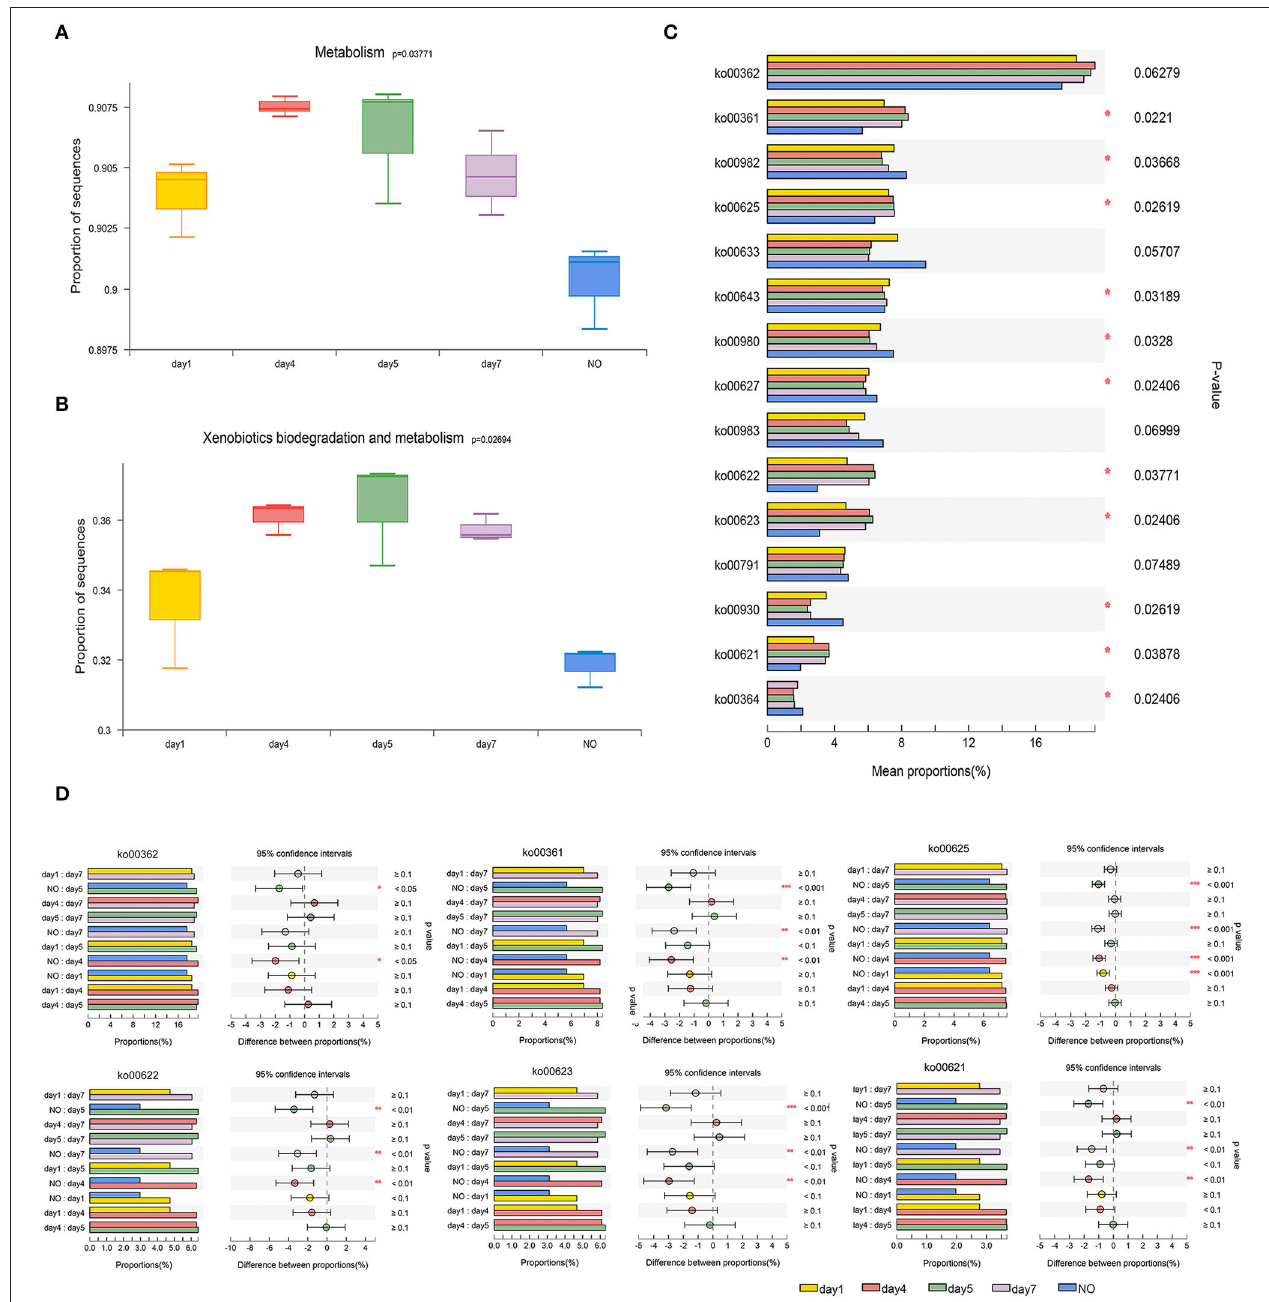
FIGURE 4 | The comparison of bacterial community functions analyzed at level 1, level 2, and level 3 between different groups. (A) and (B) Comparison of the Kyoto Encyclopedia of Genes and Genomes (KEGG) functions at level 1 related to “Metabolism” and level 2 related to “Xenobiotics Biodegradation and Metabolism”; (C) The Kruskal–Wallis (K–W) test of the top 15 abundance KEGG pathways at level 3 in the category of “Xenobiotics Biodegradation and Metabolism”; (D) Tukey-Kramer test using post-hoc analysis of six KEGG pathways. * P < 0.05, ** P < 0.01, *** P <